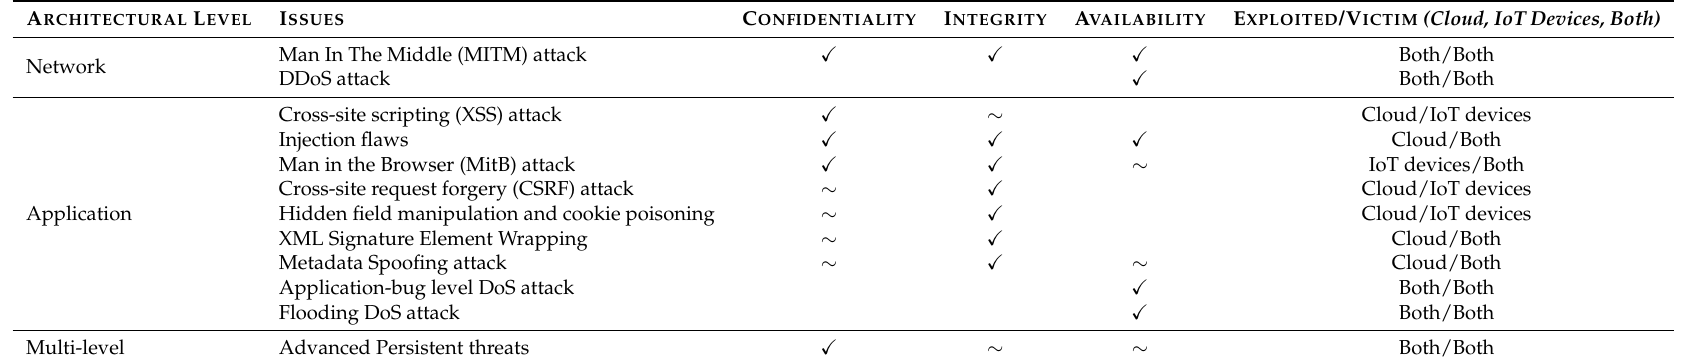
Table 2. Summary of generic security issues. “ (cid:88) ”: existence of literature works “ ∼ ”: despite we found no evidence in the literature, we believe that the issue might affect the property. E XPLOITED /V ICTIM : how parties of the IoT architecture (Figure 1) are affected from the